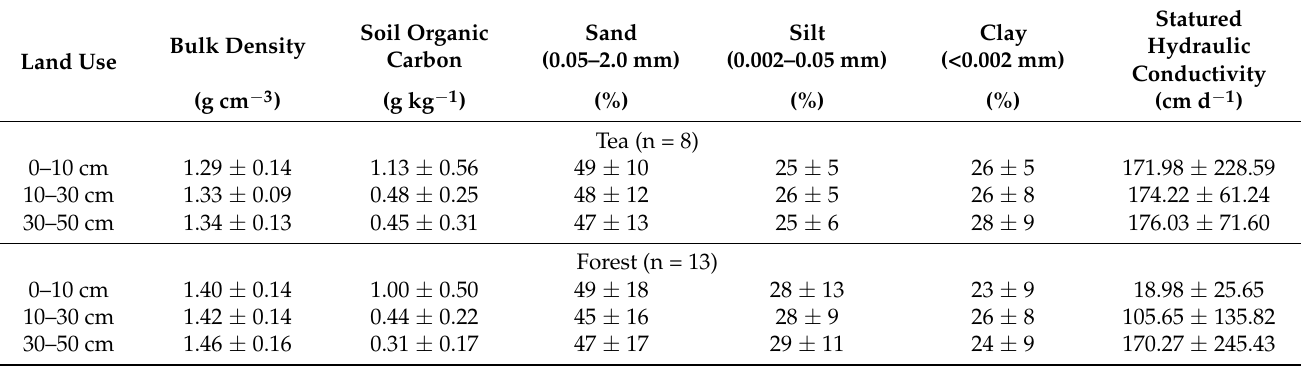
Table 2. Selected physical, chemical, and hydraulic properties by soil depth in the tea and forest